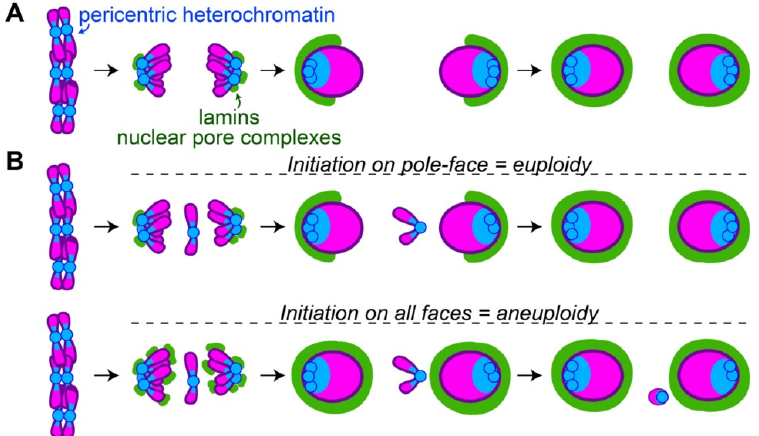
Figure 2. The pole-to-midzone pattern of nuclear envelope assembly on daughter nuclei allows retention of lagging chromosomes or trailing chromosome arms ( A ) Following chromosome segregation, the pericentric heterochromatin (blue) is grouped at pole ‐ facing edges of daughter nuclei. This location corresponds to the site of initial lamin B and nuclear pore complex (green) assembly. Assembly continues from the pole ‐ faces to the midzone ‐ faces of daughter nuclei. ( B ) The pole ‐ to ‐ midzone pattern of nuclear envelope assembly on the daughter nucleus provides extra time for a lagging chromosome to rejoin. In contrast, should nuclear envelope reassembly begin on all faces of the daughter nucleus simultaneously, the nuclear envelope on the midzone ‐ face of the nucleus would form a barrier, excluding the lagging chromosome as a micronucleus.